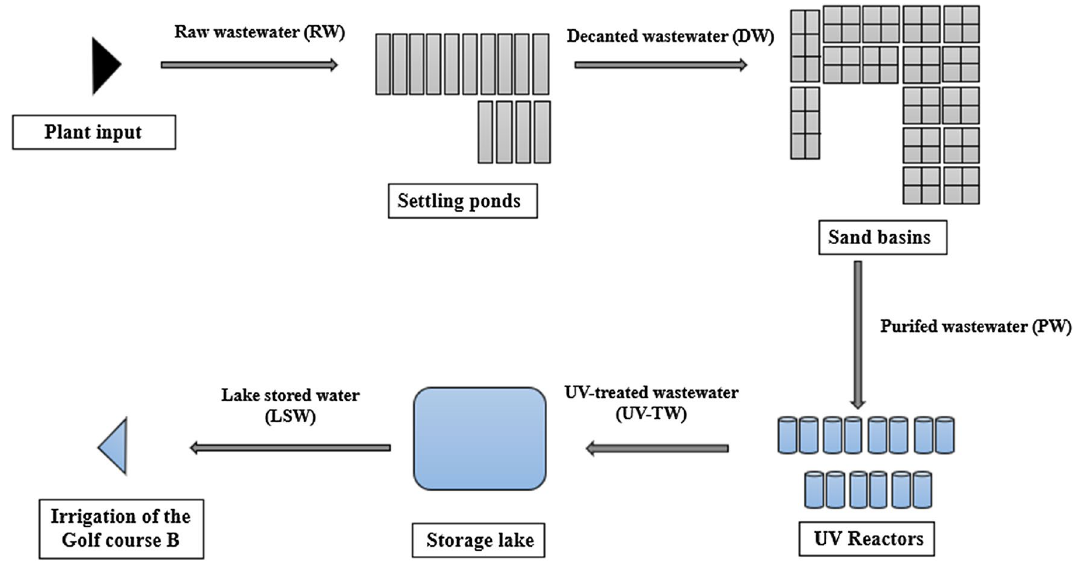
Fig. 2 Schema of M’zar wastewater treatment plant process